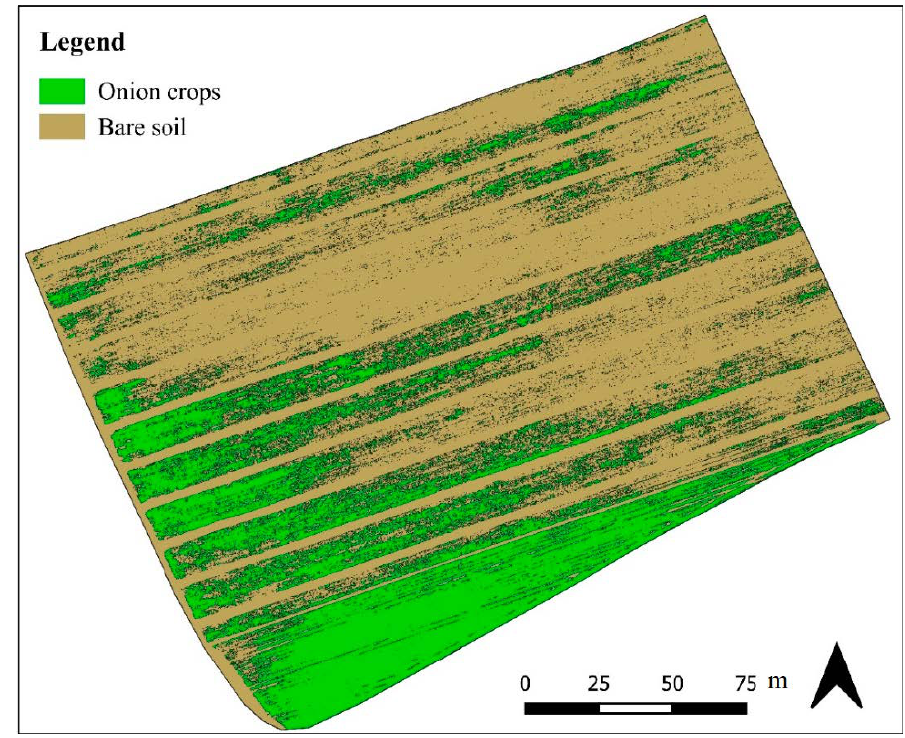
Figure 12. A map showing the image-object classification of bare soil (in brown) and onions (in green) performed using eCognition Developer. Dataset of 23 November 2018.